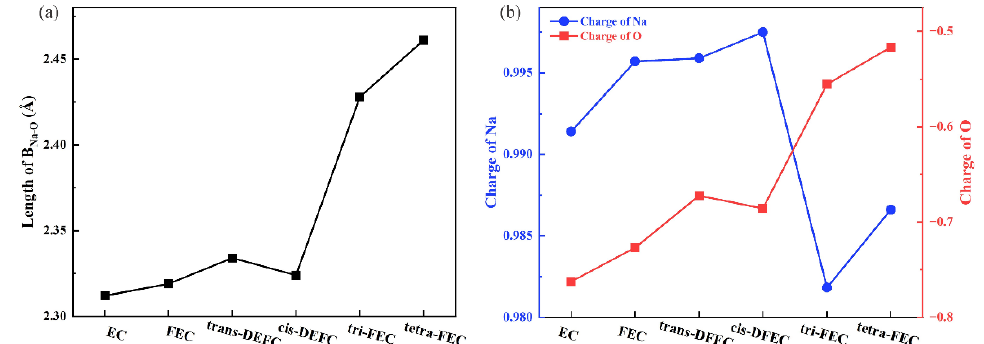
Figure 1. ( a ) Length of B Na-O , where the O atom belongs to the carbonyl group. ( b ) Atom charge of O and Na, where the O atom belongs to carbonyl group.